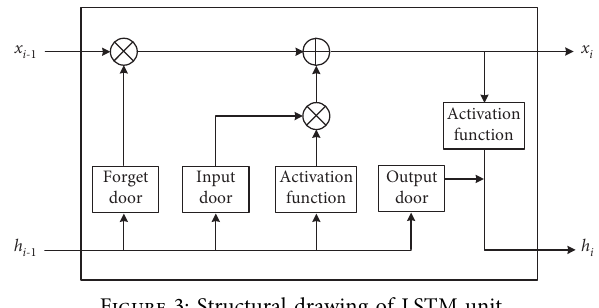
Figure 3: Structural drawing of LSTM unit.